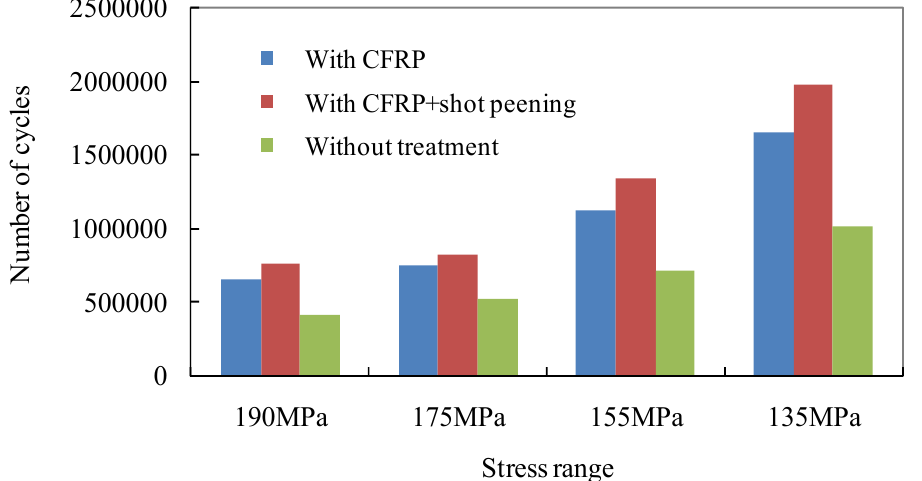
Figure 7. Comparison of fatigue life results of test joints.